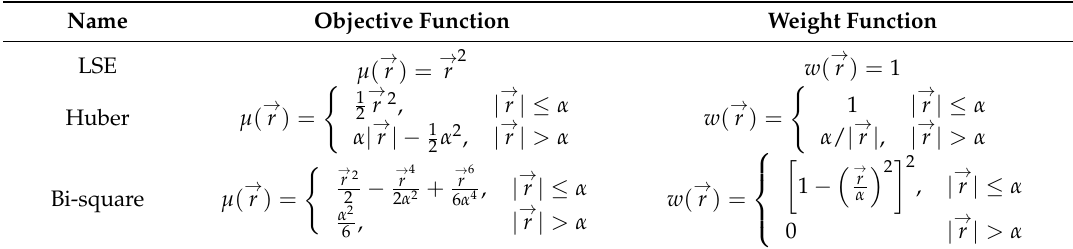
Table 1. Most popular objective and weighting